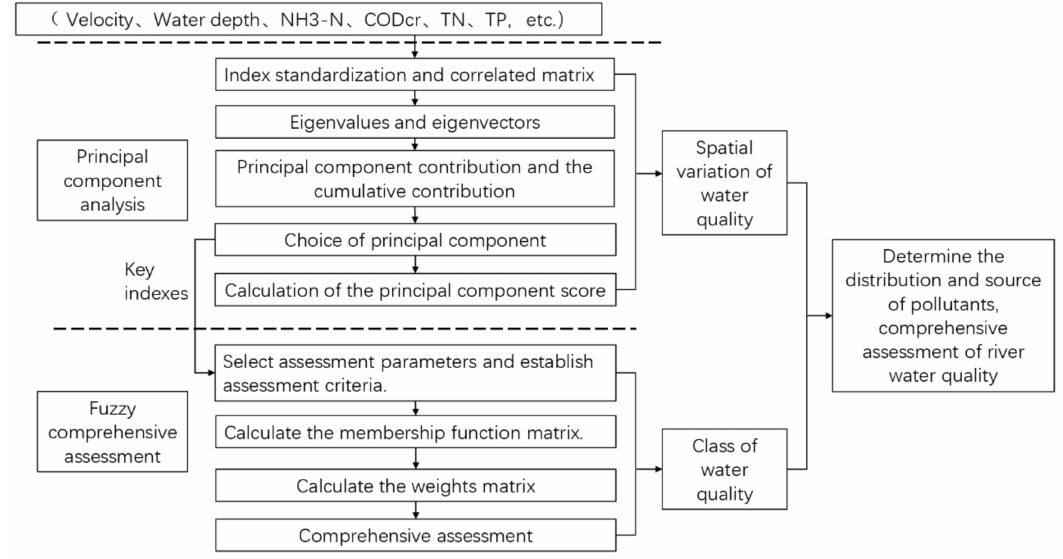
Figure 2. Flow chart of the improved principal component-fuzzy comprehensive assessment coupling